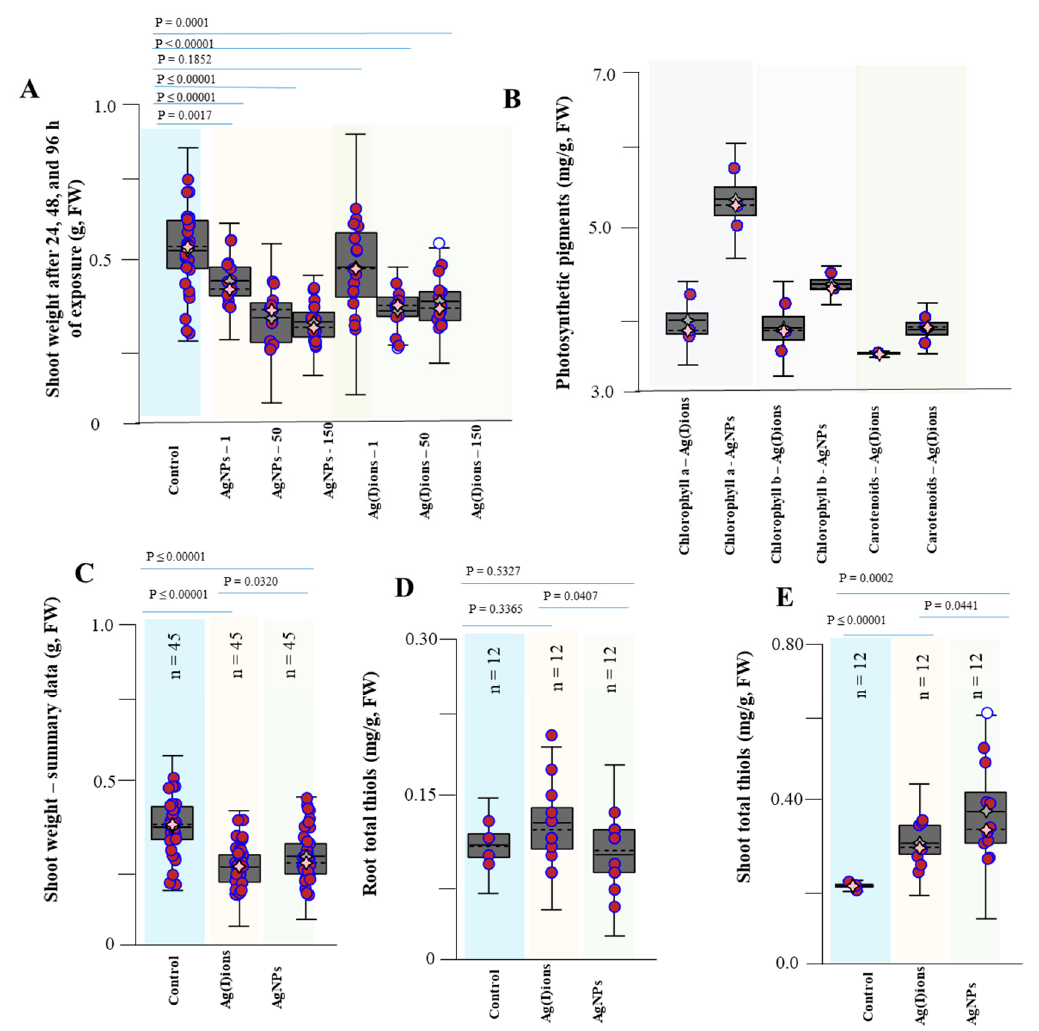
Figure 11. Changes in selected plant parameters exposed to Ag(I) and AgNPs. ( A ) Weight of the above-ground parts of plants as summary data for individual tested variants. ( B ) Changes in photosynthetic pigment contents as average values in individual variants. ( C ) Changes in the total weight of above-ground parts of plants in the Ag(I) ion and AgNPs groups. ( D ) Total thiols in roots. ( E ) Total thiols in the above-ground parts. Plants were collected after 96 h of exposure to hydroponics. Plants were collected in triplicate every day and then processed according to the procedure described in the Material and Methods section. Data are presented as the average of all experimental data.